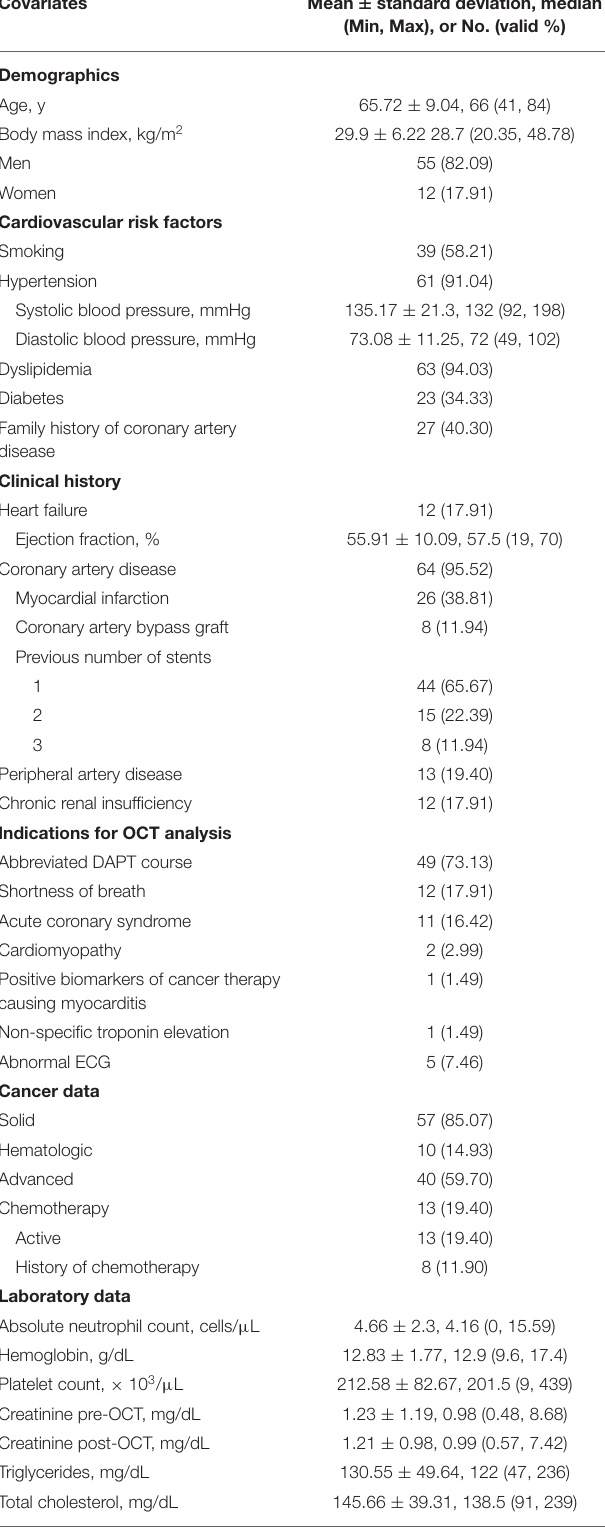
TABLE 1 | Descriptive data for the study cohort ( N = 67). Covariates Mean ± standard deviation, median (Min, Max), or No. (valid